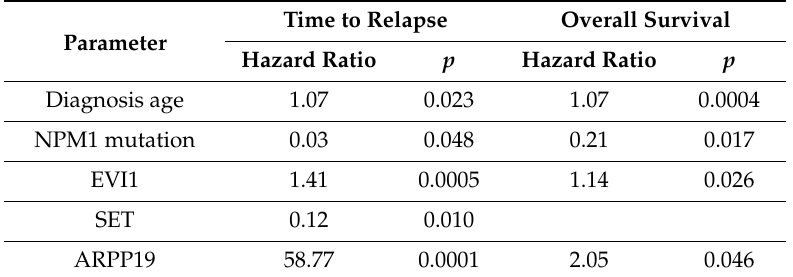
Table 2. Multivariable analysis for time to relapse and overall survival in the entire patient cohort1.